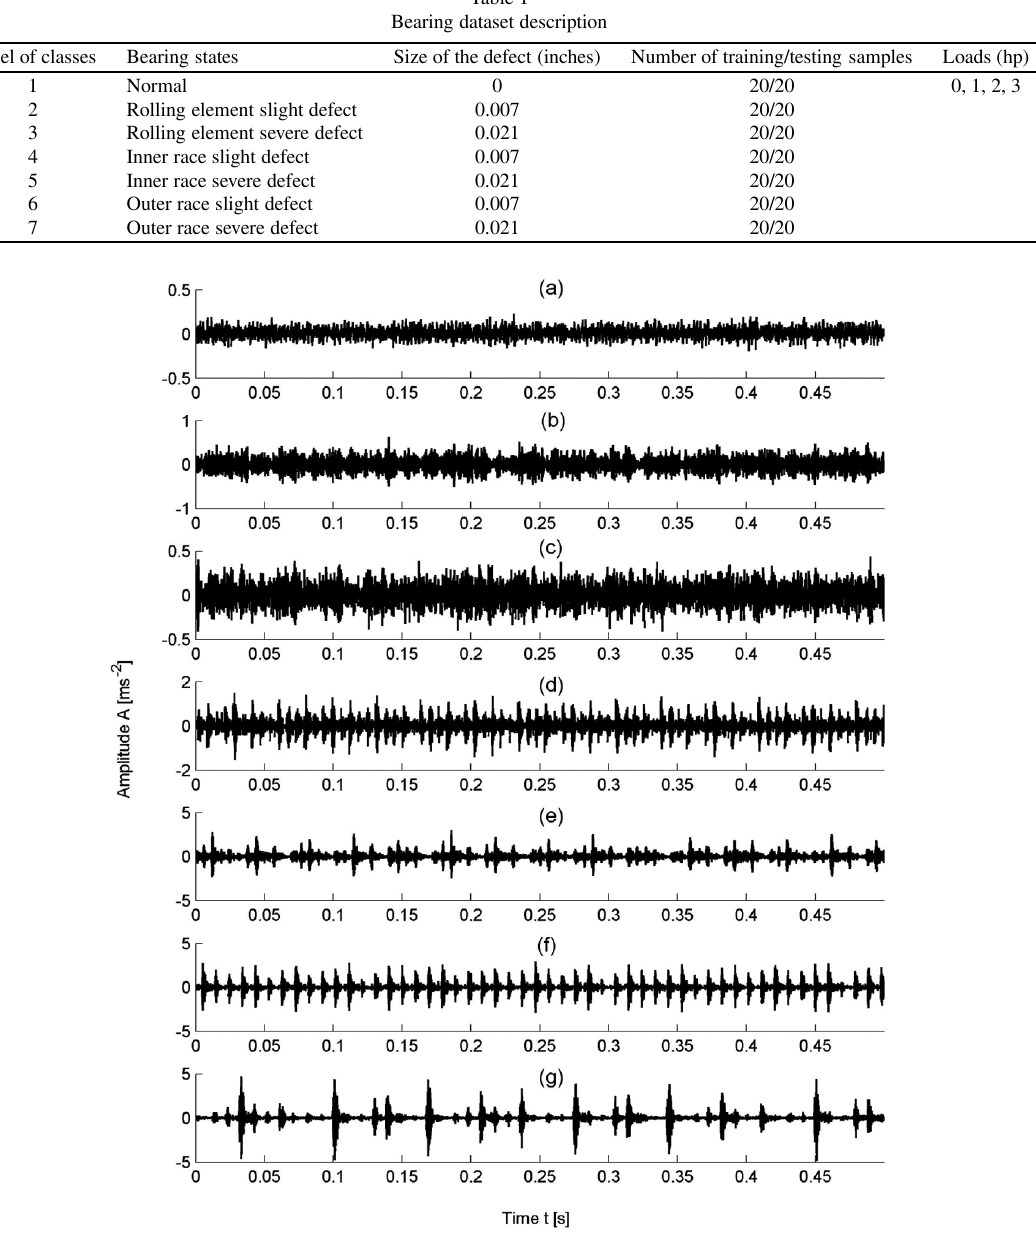
Fig. 2. Waveform of vibration signals from bearing under seven states (a)–(g) correspond to seven states (1–7) in Table 1. defect, rolling element severe defect, inner race slight defect£‹inner race severe defect, outer race slight defect and outer race severe defect) were studied in this work. The detail description of the bearing dataset was summarized in Table 1. Vibration data was collected using accelerometers, which were attached to the housing with magnetic bases. The sample frequency is 12000Hz. Forty samples containing 6000 points are collected for each bearing state under each load condition. It means that under every load condition, 280 samples were collected. Figure 2 has demonstrated the waveform of vibration signals from seven bearing states with load